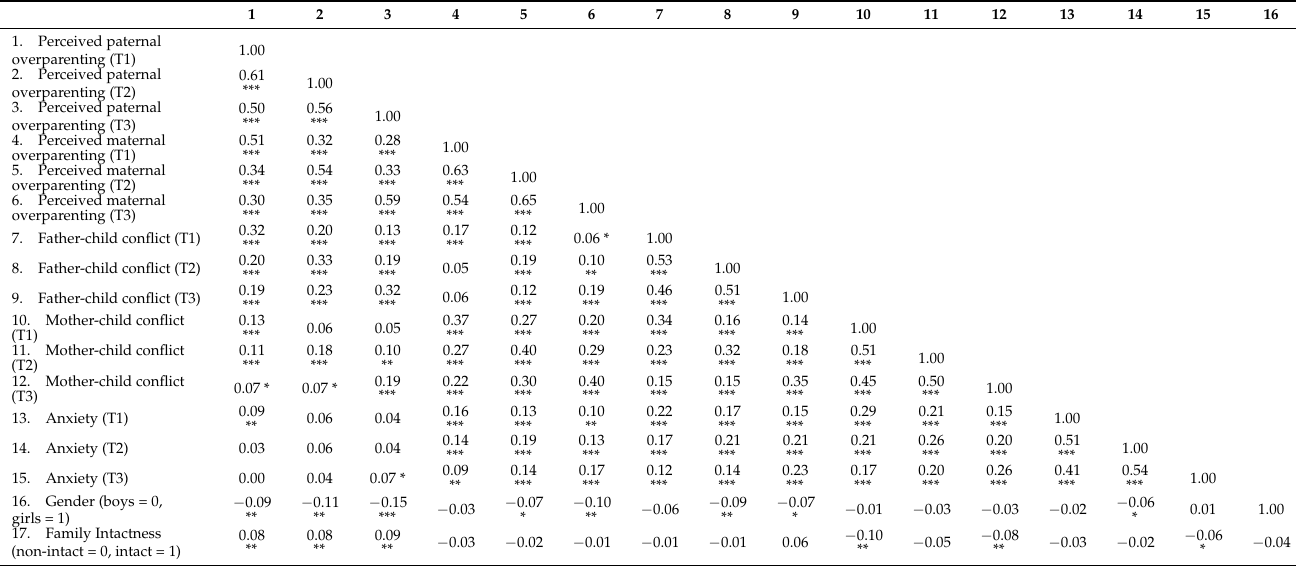
Table 2. Correlations of the